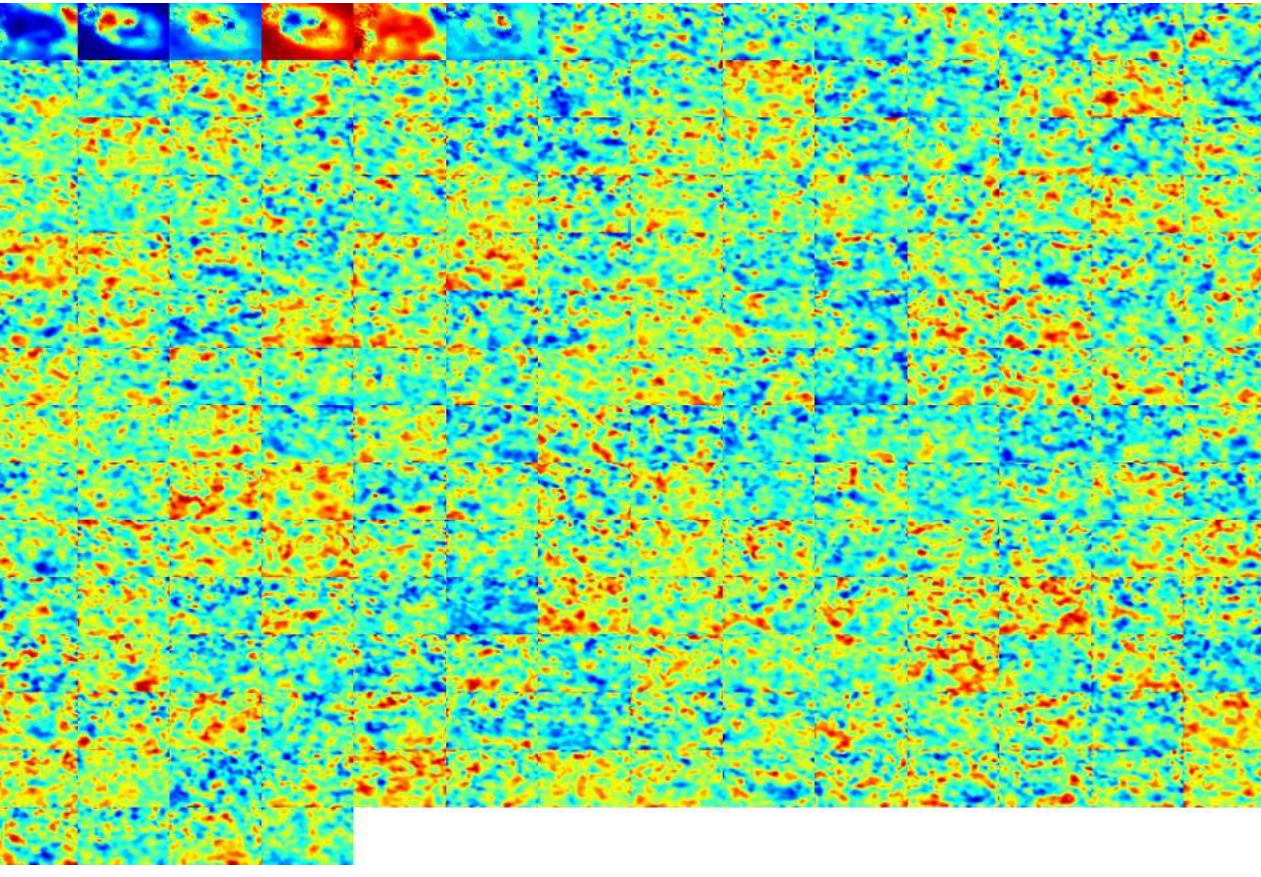
Figure 11. A total of 200 selected features were used for lithotype prediction. The selected features are sliced at an elevation of 1000 m.